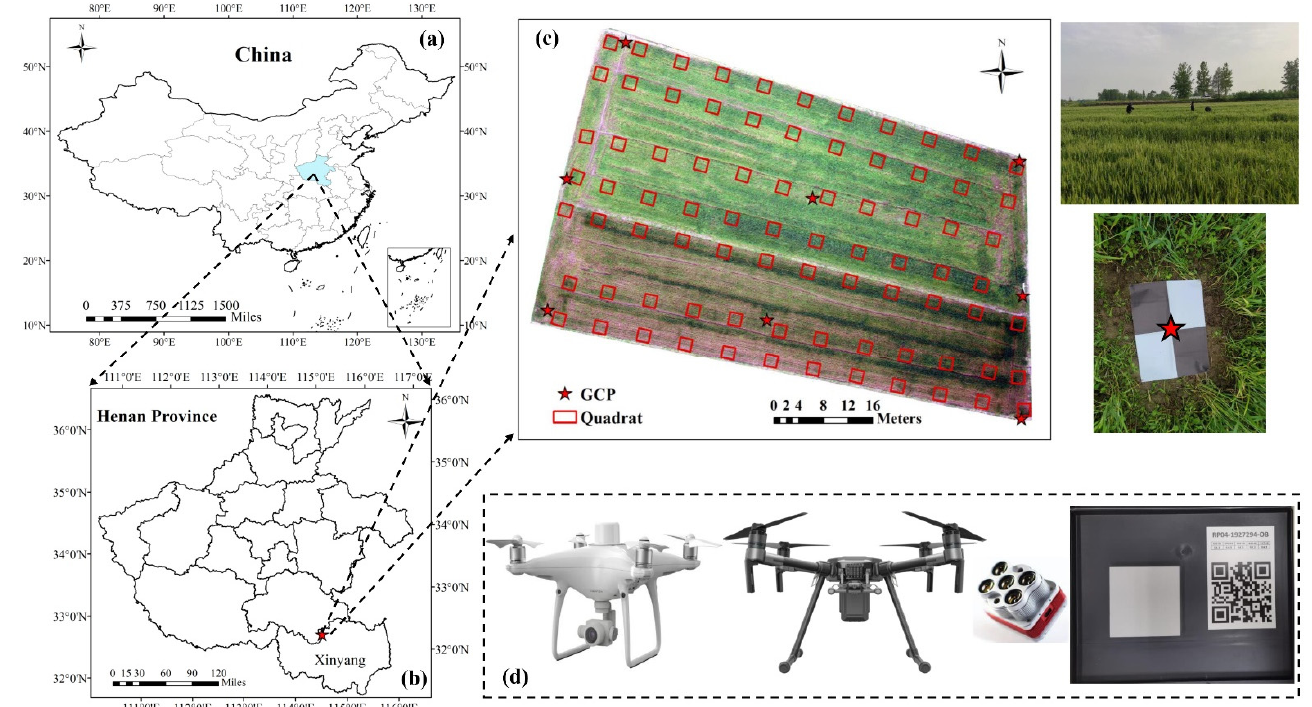
Figure 1. Overview of the study area. ( a , b ) shows the location of the experimental farm in this study; ( c ) general situation of experimental field and the distribution of LAI ground quadrat; ( d ) shows the aircraft, sensors and calibration version used for data acquisition.